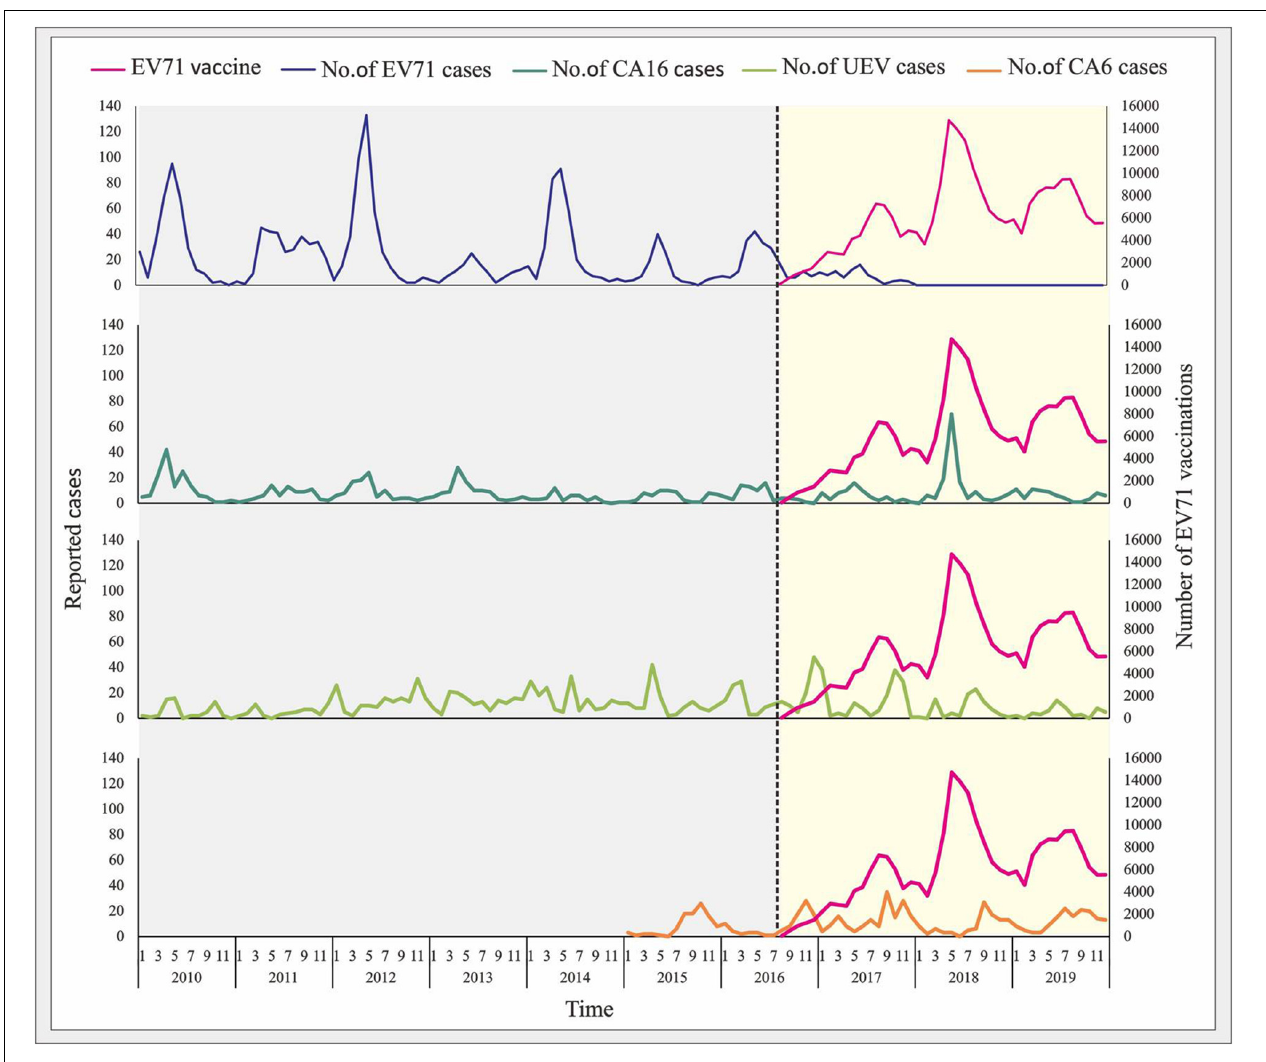
FIGURE 8 | The influence of EV-A71 vaccination on the incidence of different subtypes of HFMD. Serotyping of CV-A6 was included since 2015, and EV-A71 vaccination was initiated since July